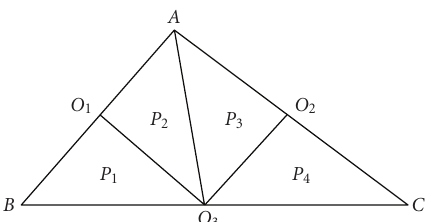
Figure 3: Triangle mesh and sampling points.